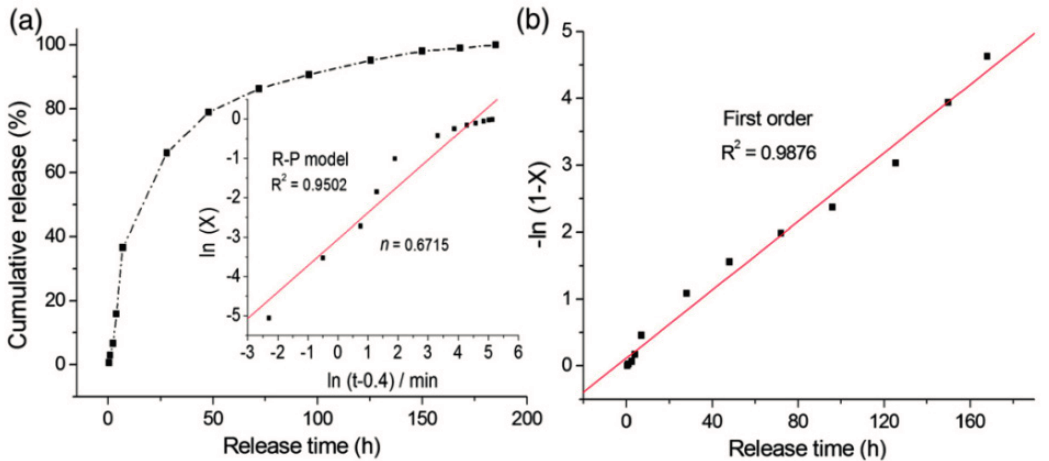
Figure 14. ( a ) Cumulative release of MTX from MgAl–LDH–MTX matrix as a function of time and ( b ) the release data fi tted to the first order kinetics model. Reprinted with permission from [92] (Copyright 2013